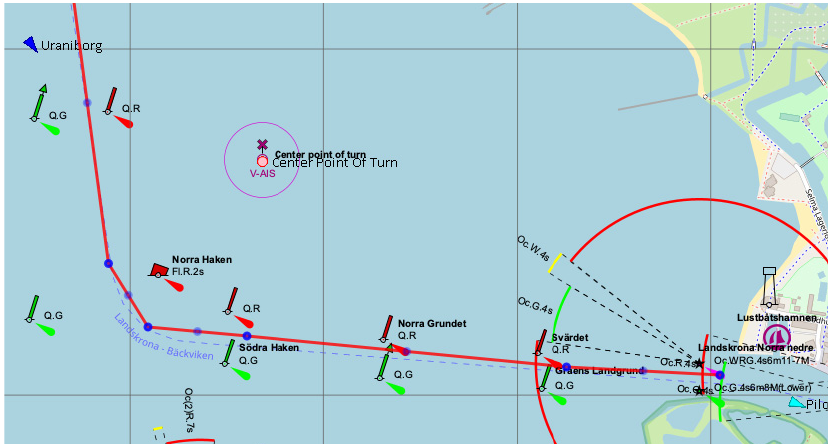
Figure 3. Approach channel bend near Landskruna port, where: QG, QR, “Nora Haken”, etc. – names of buoys; Oc.WRG.4s6m11-7M – characteristics and visibility distance of the lighthouse [21].